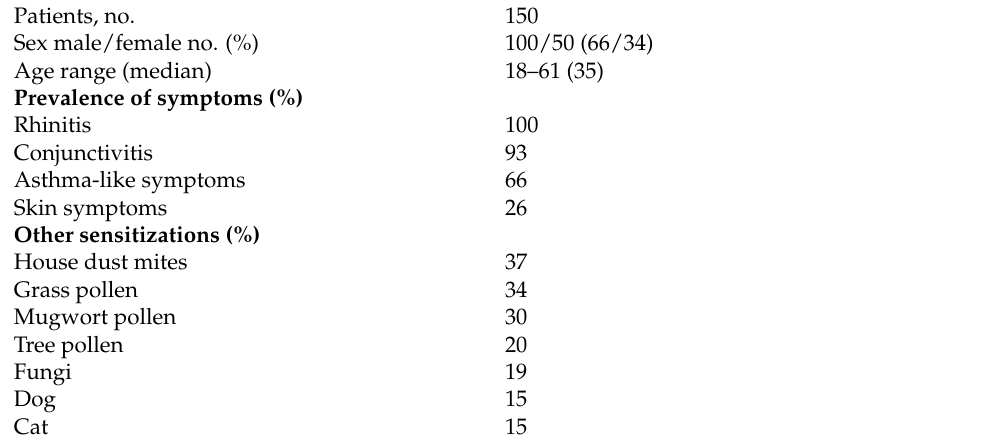
Table 1. Sensitizations and prevalence of symptoms in ragweed-allergic patients. Patients,